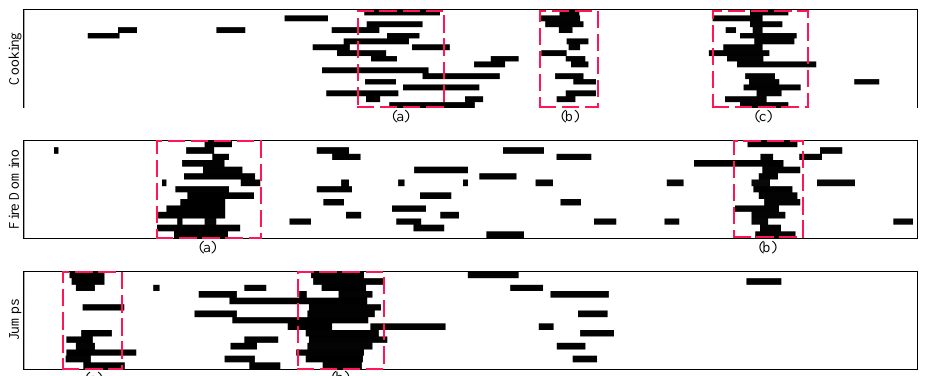
Figure 4. Visual results of human-selected labels for three example videos (cooking, fire domino, and jumps) from SumMe dataset. ( a – c ) are example labels which are selected by most